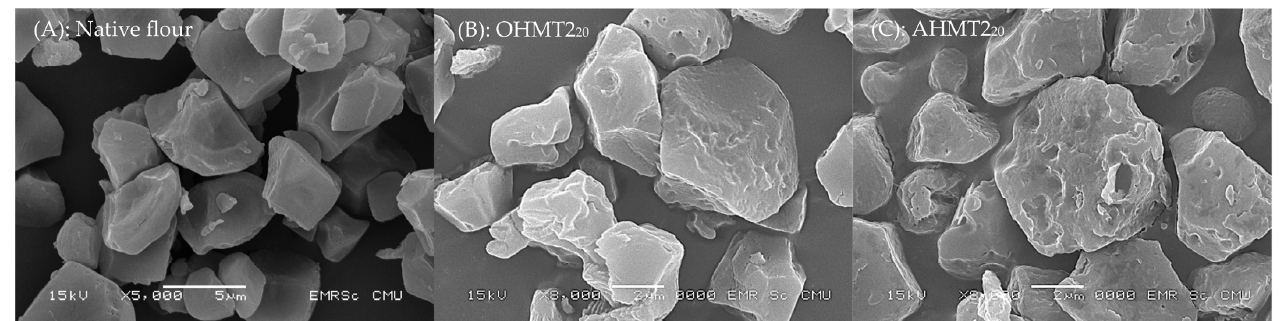
Table 5. The correlation between total phenolic content (TPC), total anthocyanin content (TAC), DPPH radical scavenging activity, and ABTS radical scavenging activity was determined using Pearson’s coefficient for all samples of purple rice flour. TPC TAC DPPH ABTS TPC 1.000 0.849 * TAC 1.000 0.858 * DPPH 1.000 0.993 * ABTS 1.000